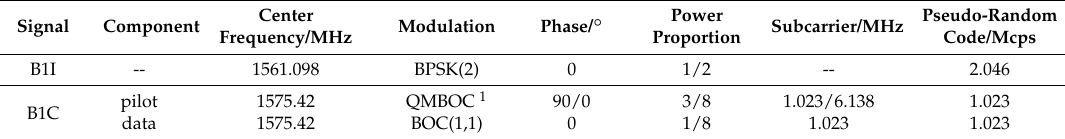
Table 1. B1I and B1C Signal